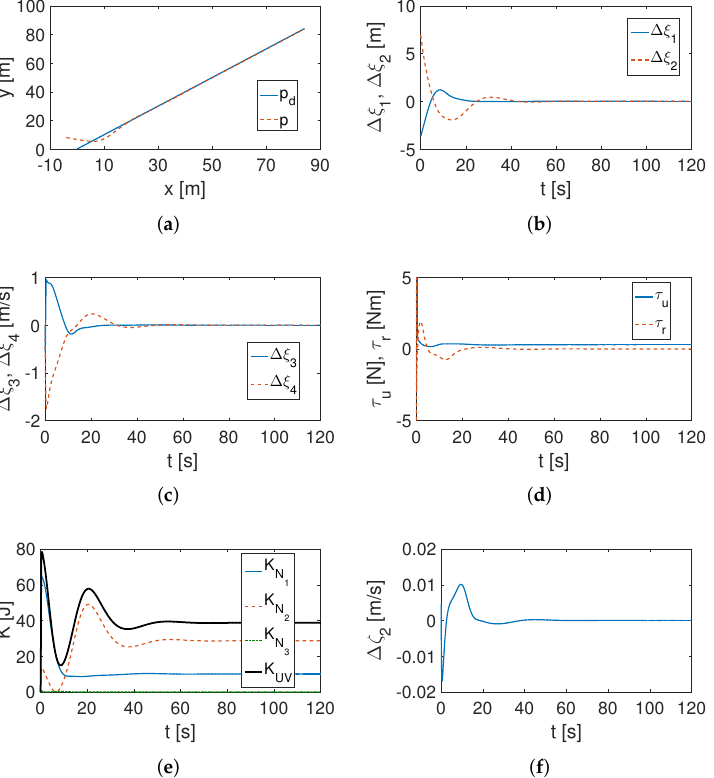
Figure 6. Simulation results for XX AUV QV controller and linear trajectory: ( a ) desired and realized trajectory; ( b ) position error states; ( c ) velocity error states; ( d ) applied force and torque; ( e ) kinetic energy time history; and ( f ) error ∆ ζ 2 .